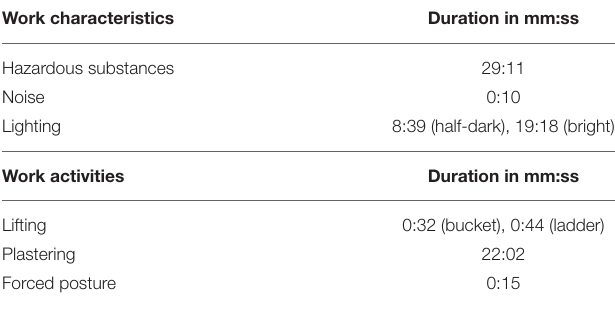
TABLE 2 | Work characteristics and work activities.